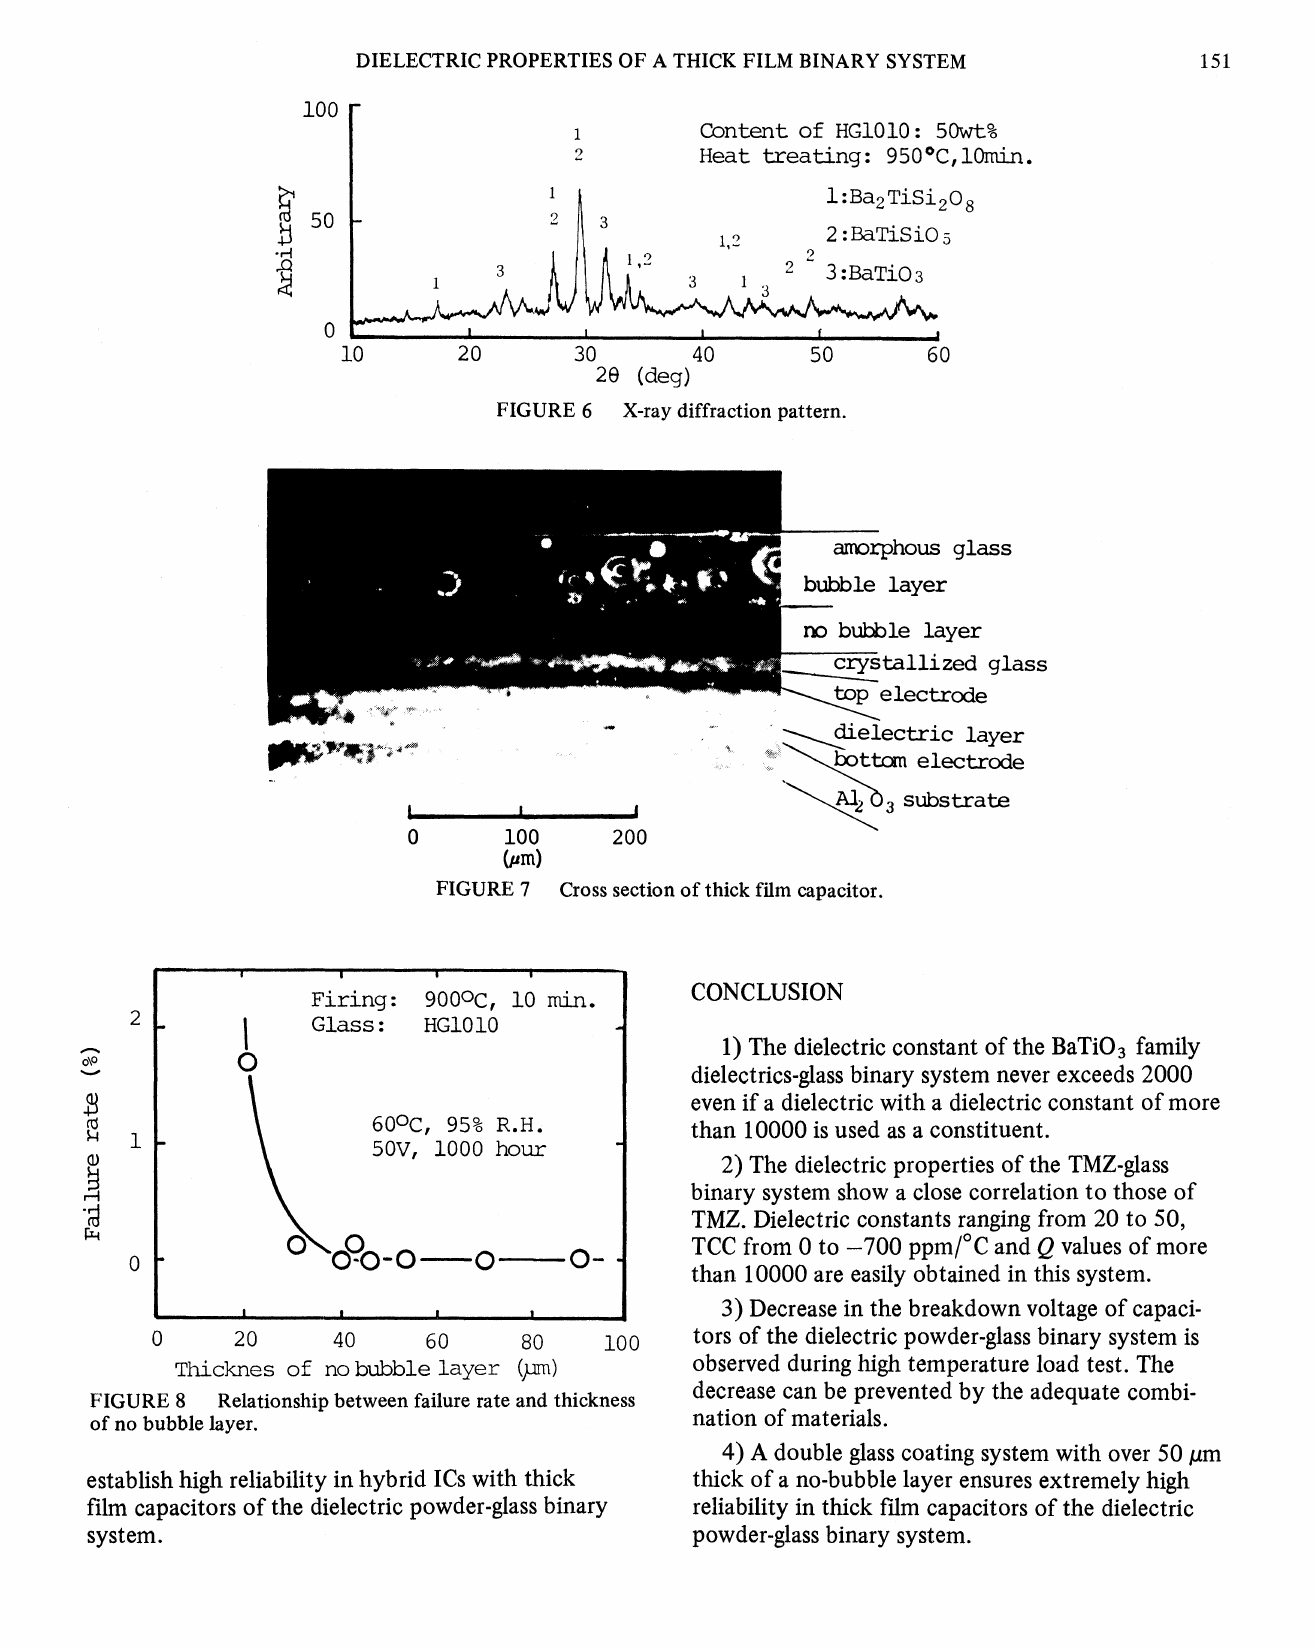
FIGURE 8 Relationship between failure rate and thickness of no bubble layer. establish high reliability in hybrid ICs with thick film capacitors of the dielectric powder-glass binary